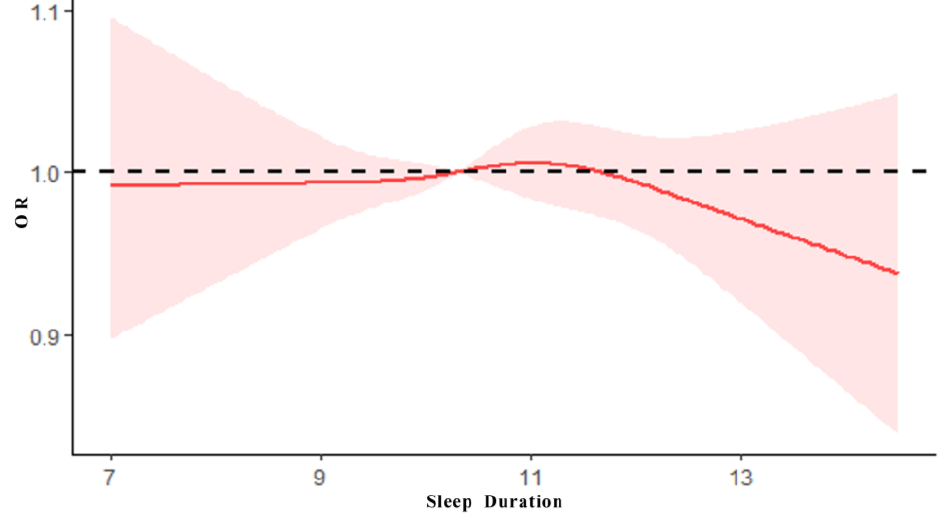
Figure 1. The dose – effect relationship between sleep duration and PF. Figure 1. The dose–effect relationship between sleep duration and PF.